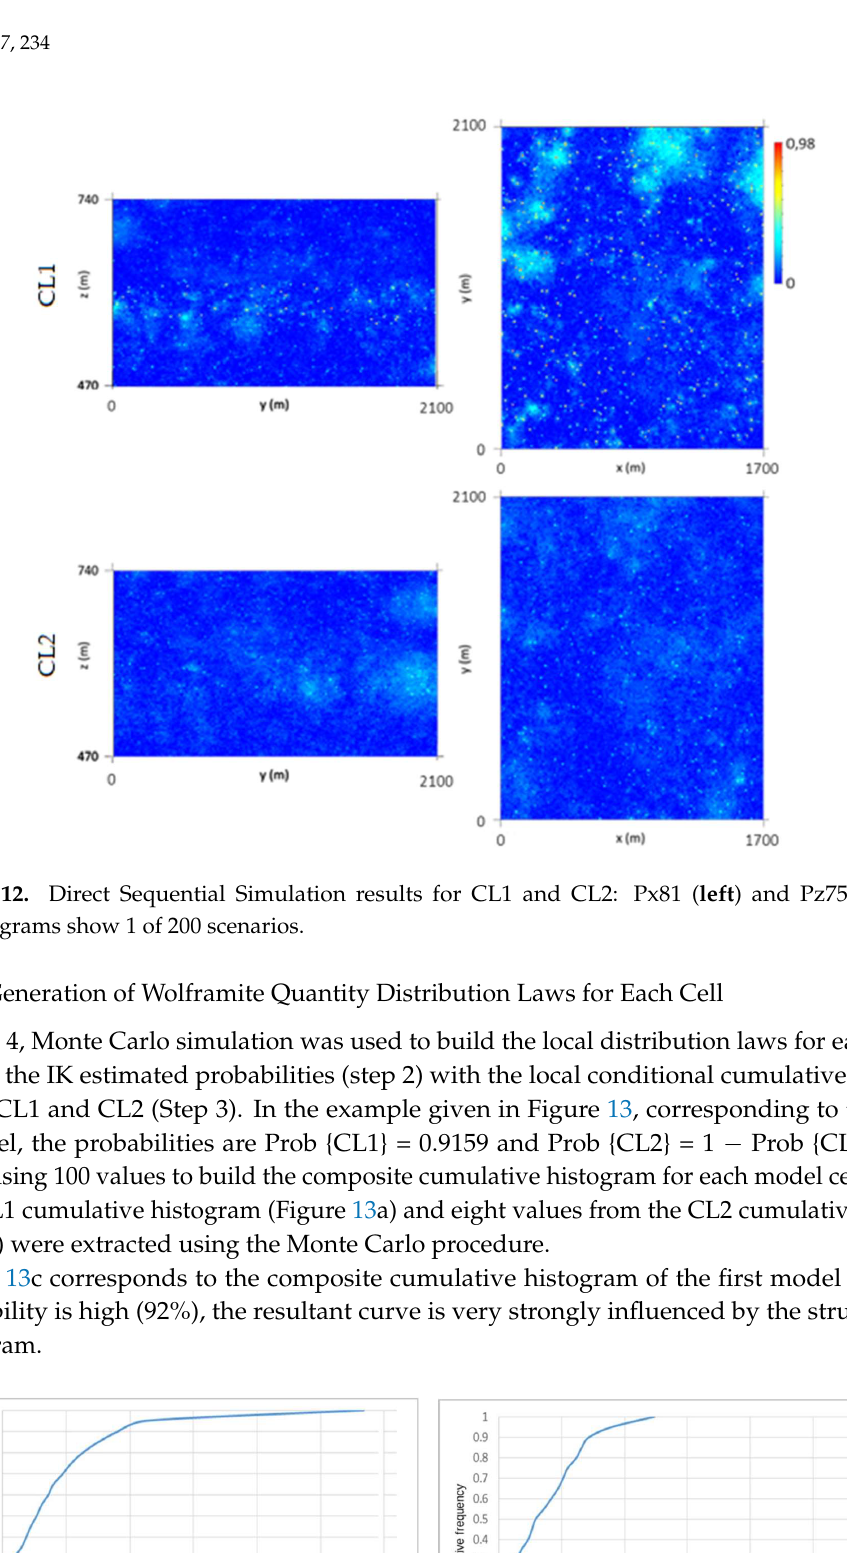
Figure 10. Conditional cumulative histograms for L0: ( a ) for each class and ( b ) for grouped classes.